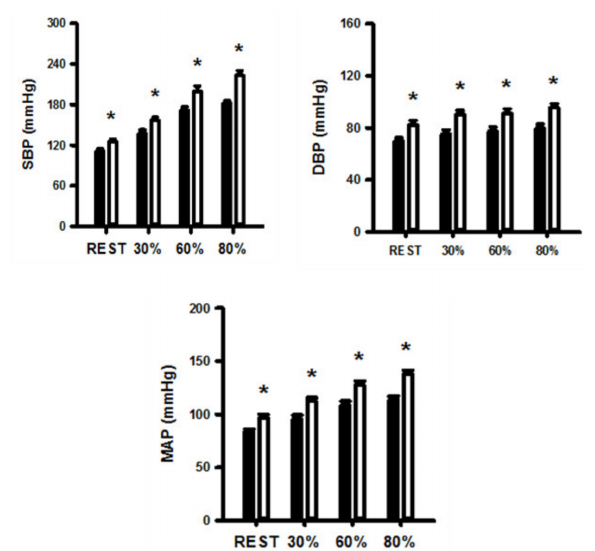
Figure 5. Systolic blood pressure (SBP), diastolic blood pressure (DBP), and mean arterial pressure (MAP) at rest and during dynamic exercise in both normal and obese individuals. Black bar, normal; open bar, obese. * p < 0.05, vs. normal individuals.